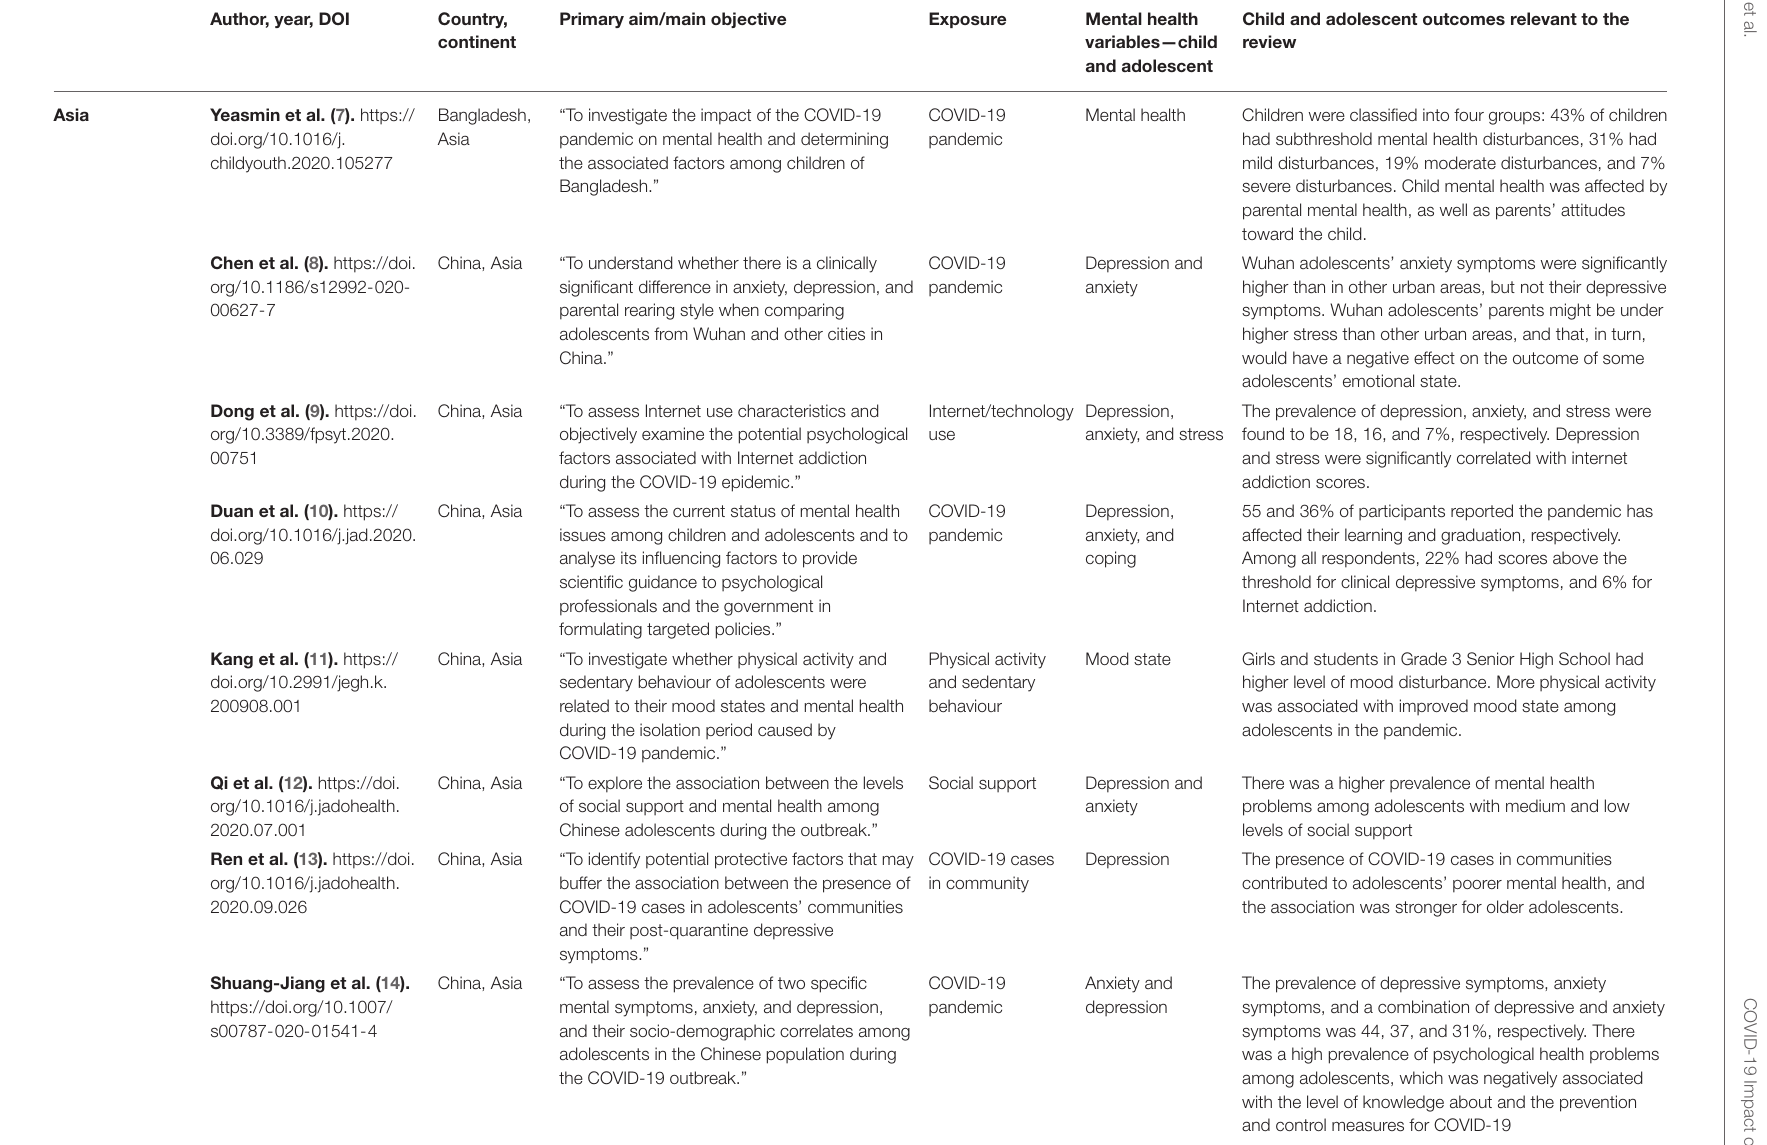
TABLE 2 | Overview of cross-sectional studies organised by continent and